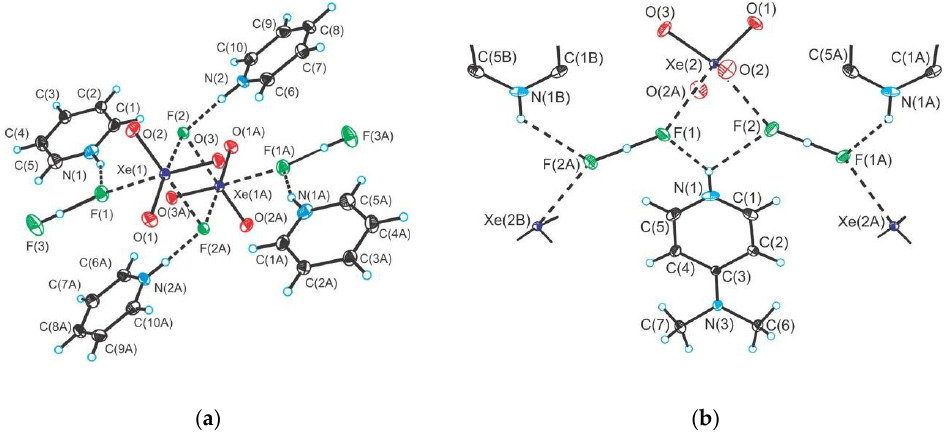
Figure 18. ( a ) The X-ray crystal structure of [C 5 H 5 NH] 4 [HF 2 ] 2 [F] 2 (XeO 3 ) 2 ; ( b ) The X-ray crystal